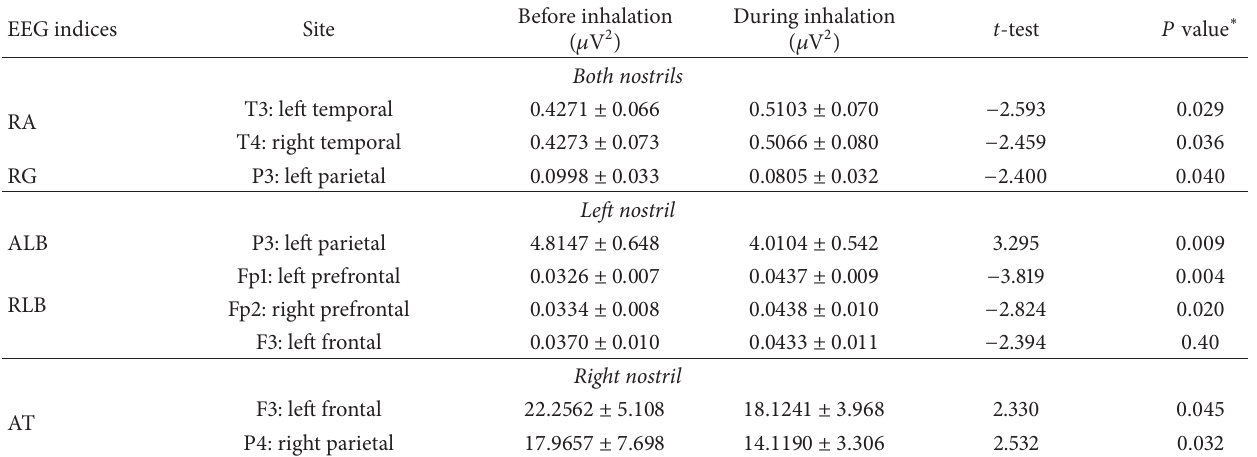
Table 6: Effect of inhalation of essential oil of A. koreana twigs on EEG activity in men (both, left, and right nostrils). EEG indices